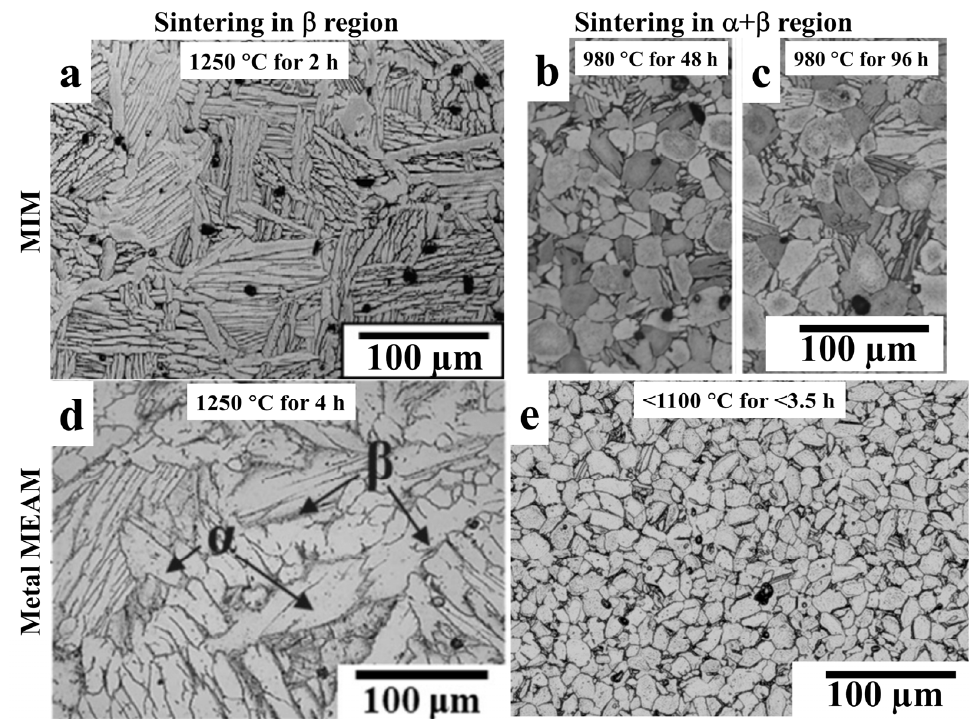
Figure 14. Microstructure comparison of Ti-6Al-4V parts ( a ) fabricated by MIM process sintered in the β region (Reprinted with permission from [171]. Copyright 2009, Materials Science and Engineering: A, Elsevier), ( b , c ) fabricated by MIM process sintered in the α + β region (adapted from [163]), ( d ) fabricated by metal MEX process sintered in the β region (Reprinted with permission from [78]. Copyright 2021, Powder Technology, Elsevier). and ( e ) fabricated by metal MEX process sintered in the α + β region for grain refinement (adapted from [109]).